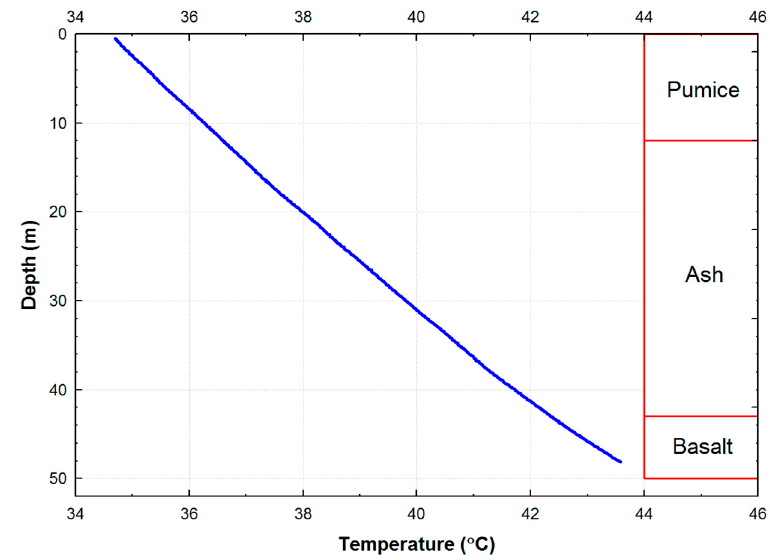
Figure 5. Temperature profile of well W1 (the maximum temperature was 43.5 °C to a depth of 48.0 m), including a lithology profile (right side).